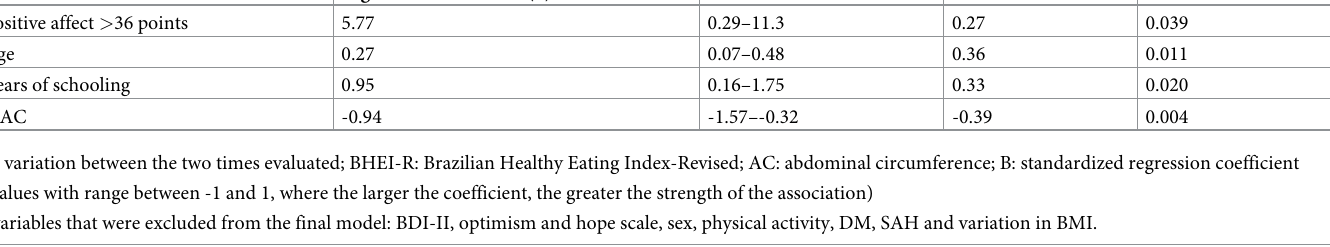
(values with range between -1 and 1, where the larger the coefficient, the greater the strength of the association) � variables that were excluded from the final model: BDI-II, optimism and hope scale, sex, physical activity, DM, SAH and variation in